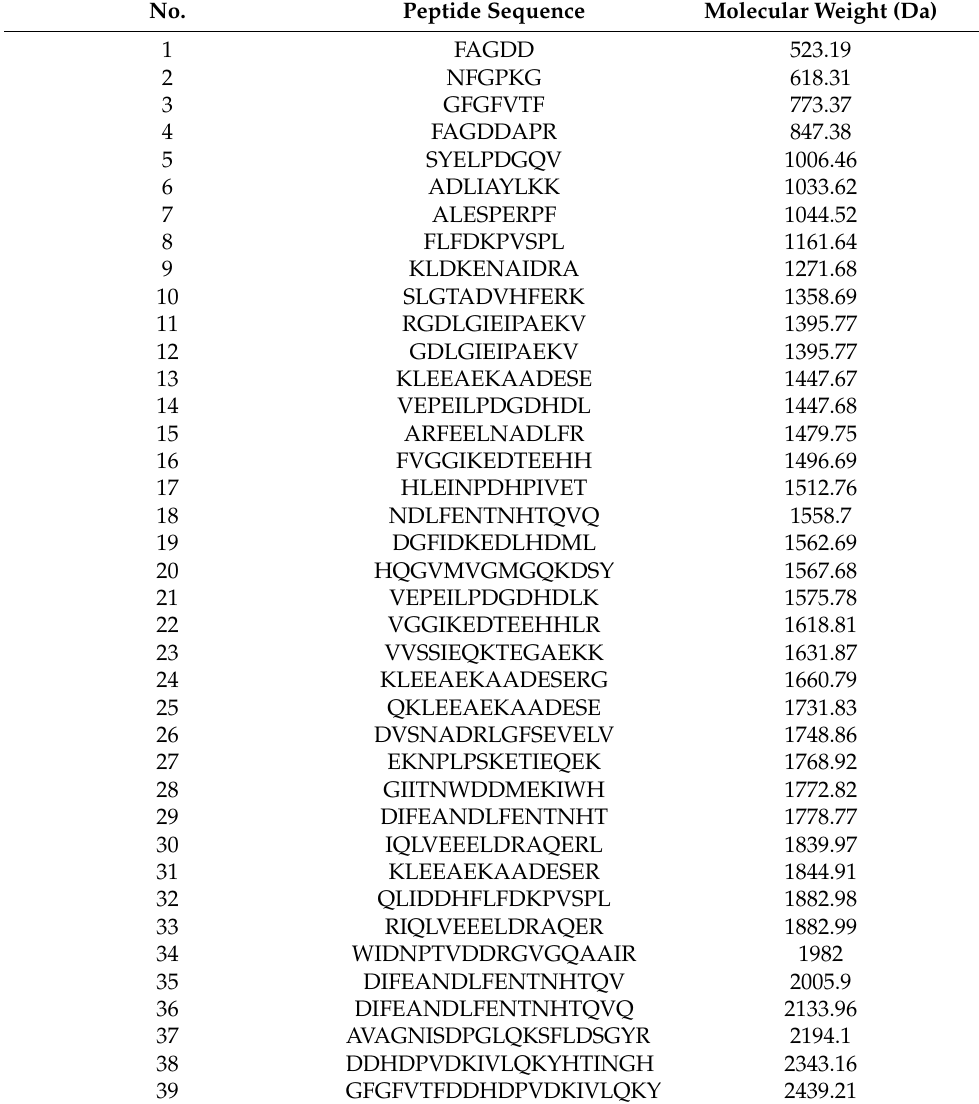
Table 1. The sequence description of EWP-Ca